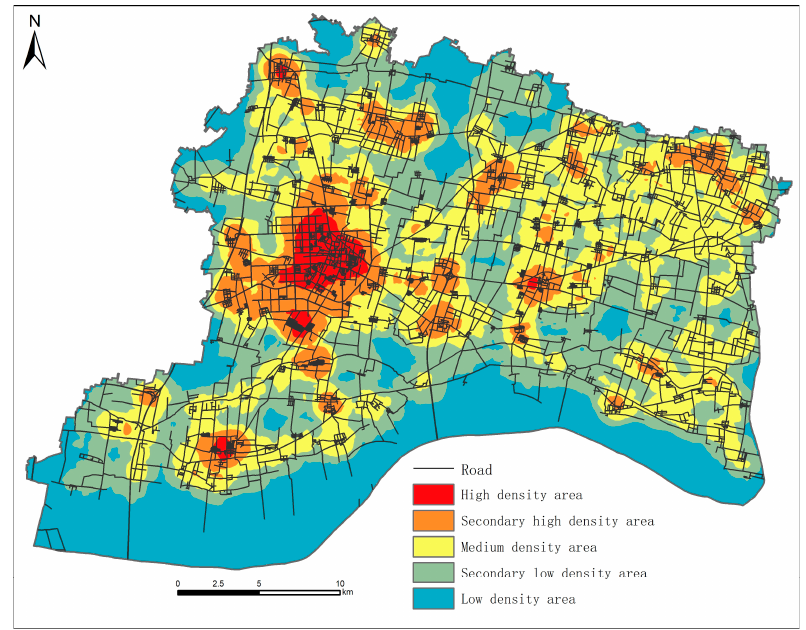
Figure 3. Density analysis of road network in Yuanyang County.